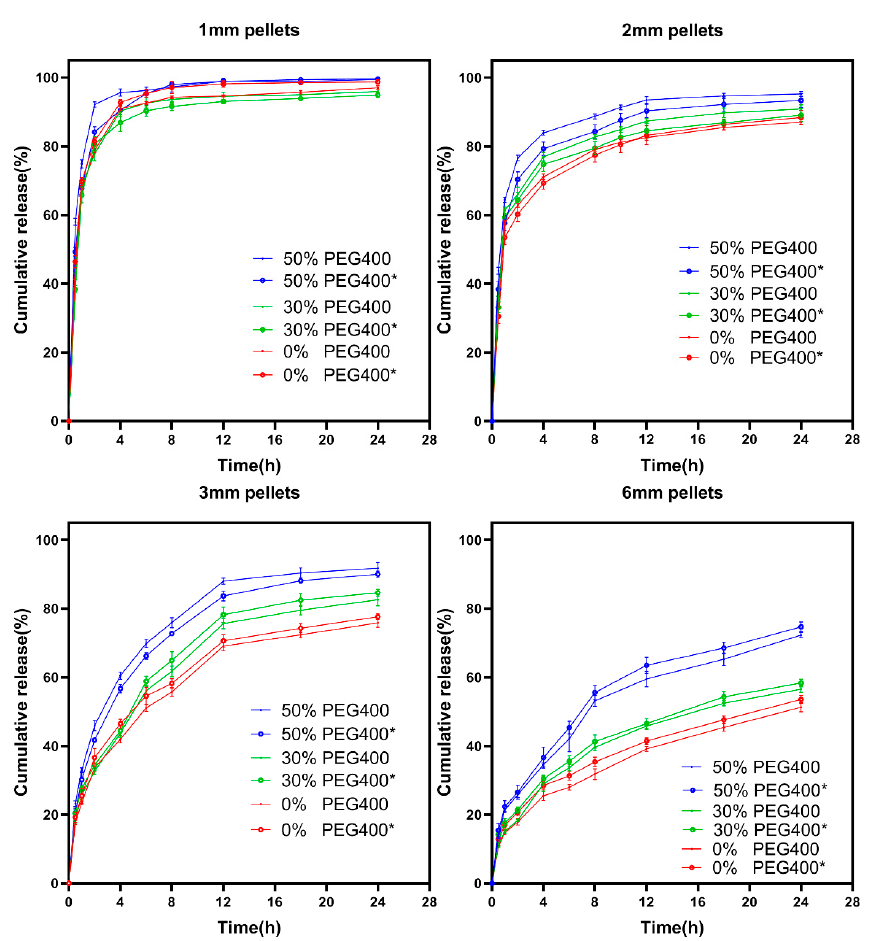
Figure 10. Drug release profile from different sized pellets with different PEG400 contents after stability tests (* = after storage at 40 °C, 75% RH for 1 month). Table 5. Similarity factors of pellets with different size and formulation after stability tests.